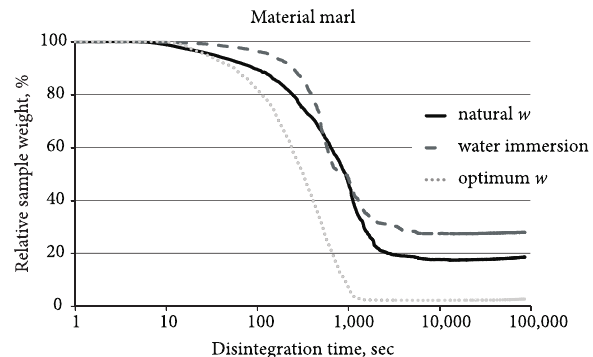
clayFig. Fig. 12. Disintegration curves (Weißmann) of marsh Fig. 13. Total disintegration with different mass